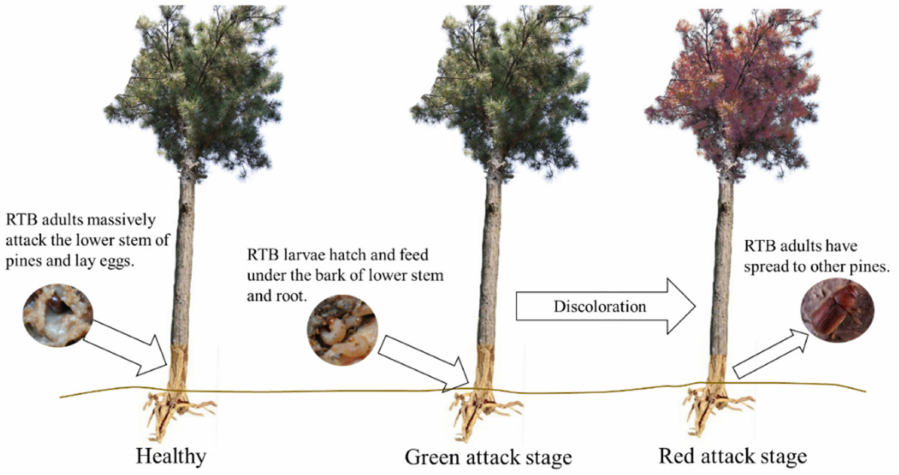
Figure 1. Diagram of RTB attack